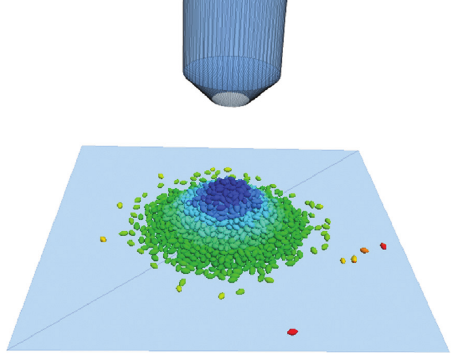
Figure 4: DEM hopper flow test model. Table 1: Simulation parameters in DEM of the hopper flow